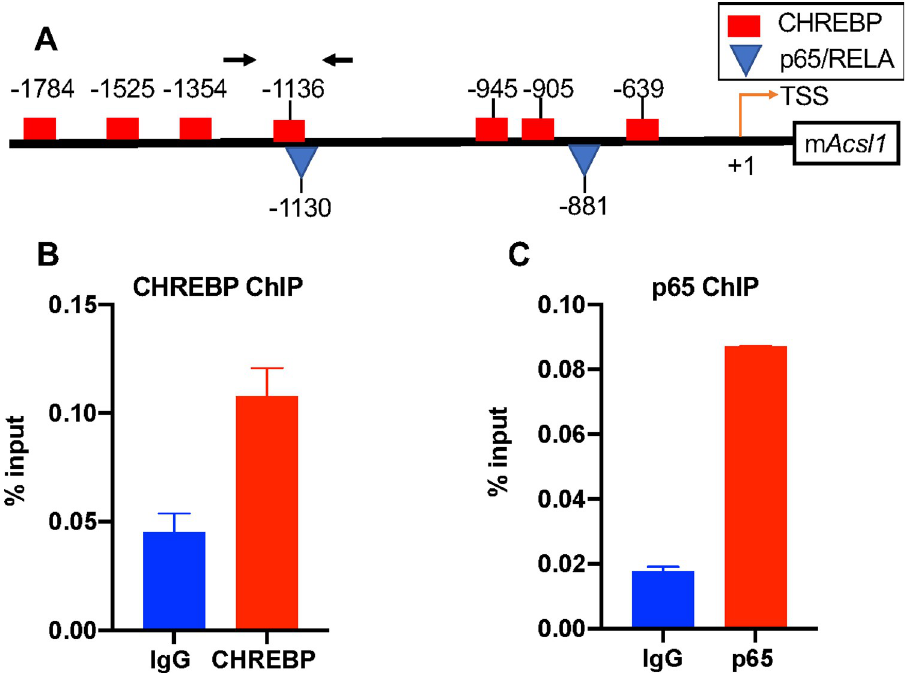
Fig 6. CHREBP and p65/RELA occupy the mouse Acsl1 gene. A) Putative binding sites of CHREBP and p65/RELA on mouse Acsl1 . Arrows denote the region amplified by qPCR. B) Chromatin was immunoprecipitated from BMDMs differentiated in HG using an antibody against CHREBP and isotype-matched IgG control. C) Chromatin was immunoprecipitated from BMDMs differentiated in HG and stimulated with LPS (10ng/mL) for 1 hour using an antibody against p65/RELA along with isotype-matched IgG control. Percent of precipitated DNA compared to total input DNA is shown. The data are means with an error bar representing the spread of the mean from two independent